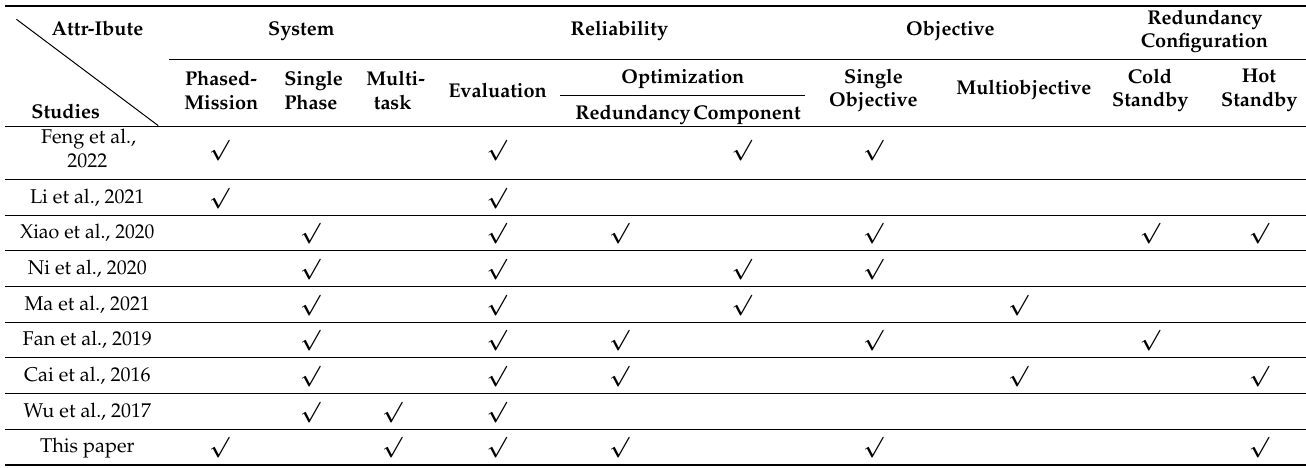
Table 1. Comparison of the related